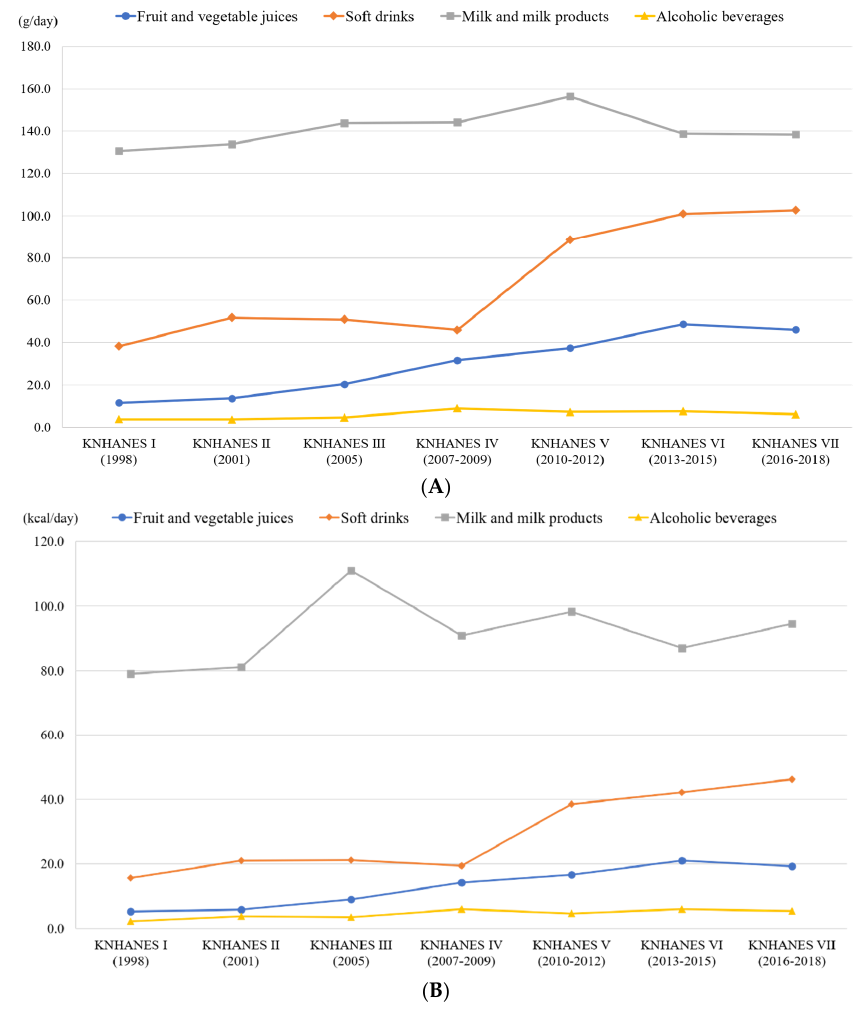
Figure 1. ( A ) Trends in consumption (g/day) by beverage types from 1998 to 2018 among Korean Figure 1. Trends in beverage consumption by beverage types from 1998 to 2018 among Korean children children and adolescents. ( B ) Trends in calorie intake (kcal/day) by beverage types from 1998 to 2018 and adolescents. ( A ) Trends in consumption (g / day) by beverage types from 1998 to 2018 among among Korean children and adolescents. Korean children and adolescents. ( B ) Trends in calorie intake (kcal / day) by beverage types from 1998 to 2018 among Korean children and